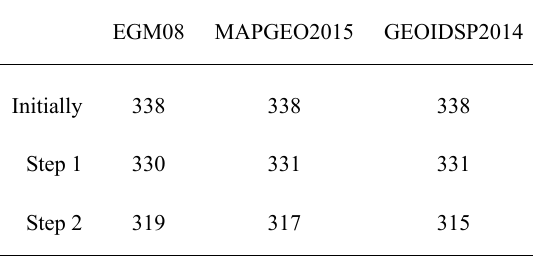
Discrepancies between the undulations of hybrid models and benchmarks tracked by GNSS, which did not participate in the model generation (10%), were used for validation. For comparative purposes, the statistics of validation points for gravimetric geoids are shown in Table V.